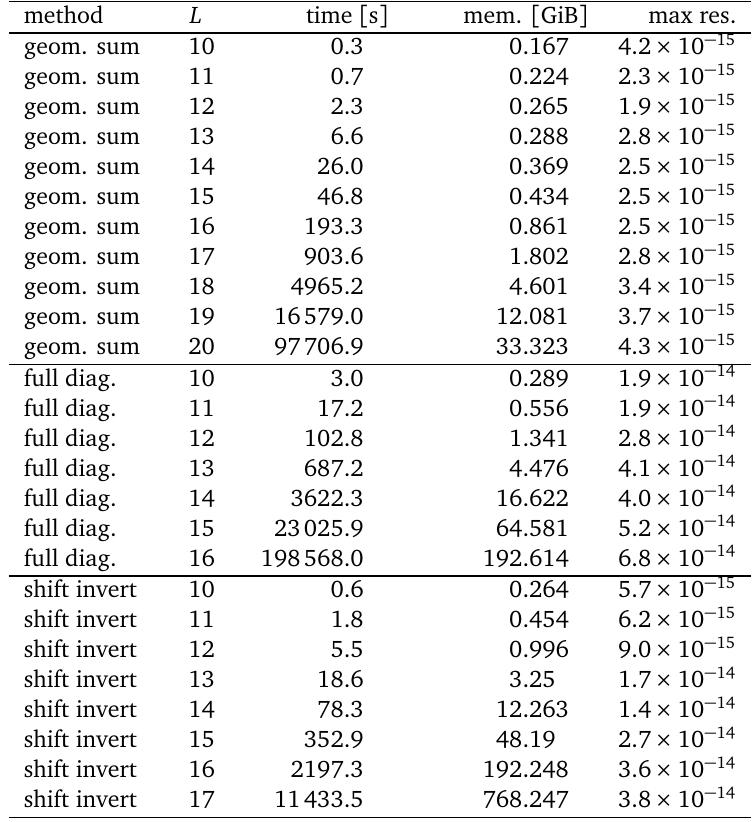
Table 1: Average runtime and memory consumption for the calculation of n = 1 of our proposed geometric sum polynomial filter method eigenpairs close to z tgt = (cid:98) 2 L / 2 + 1 (cid:99) and the optimal polynomial order k = 0.8 · 2 L + 1 / n with n cv in comparison with full diagonalization using MKL’s zgeev , as well as a custom shift invert implementation using MKL’s zgetrf . Runtimes were measured using 16 cores of an AMD EPYC 7H12 2.6 GHz CPU. Memory usage is estimated from the maximum resident set size (max RSS). Memory footprints are only indicative since our simple benchmark codes were not optimized for memory